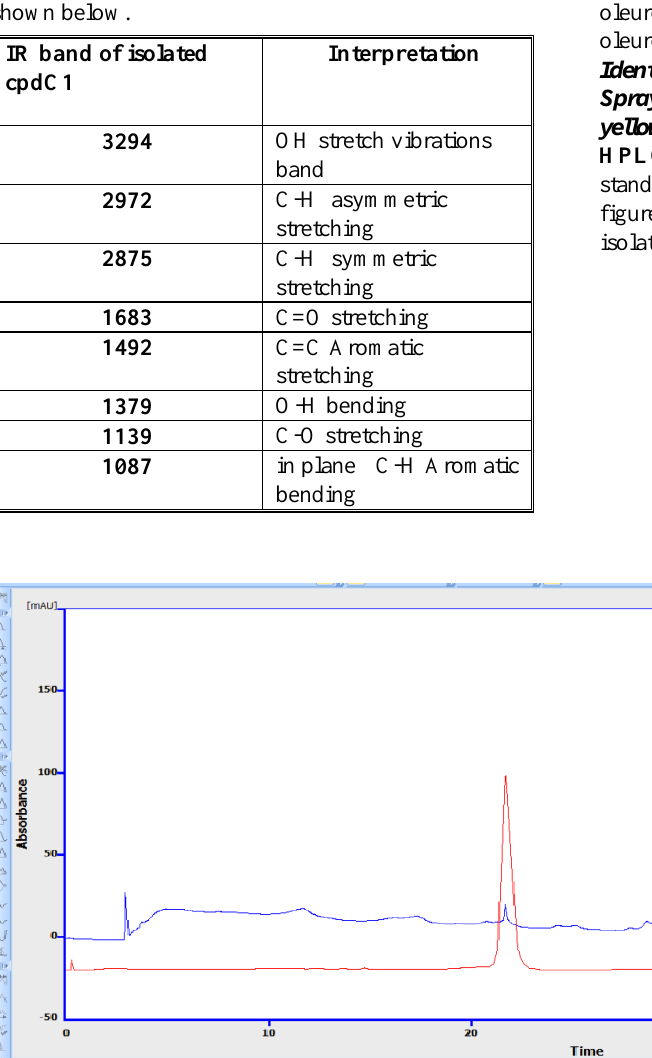
Figure 14. HPLC chromatogram of standard genistein and isolated cpd